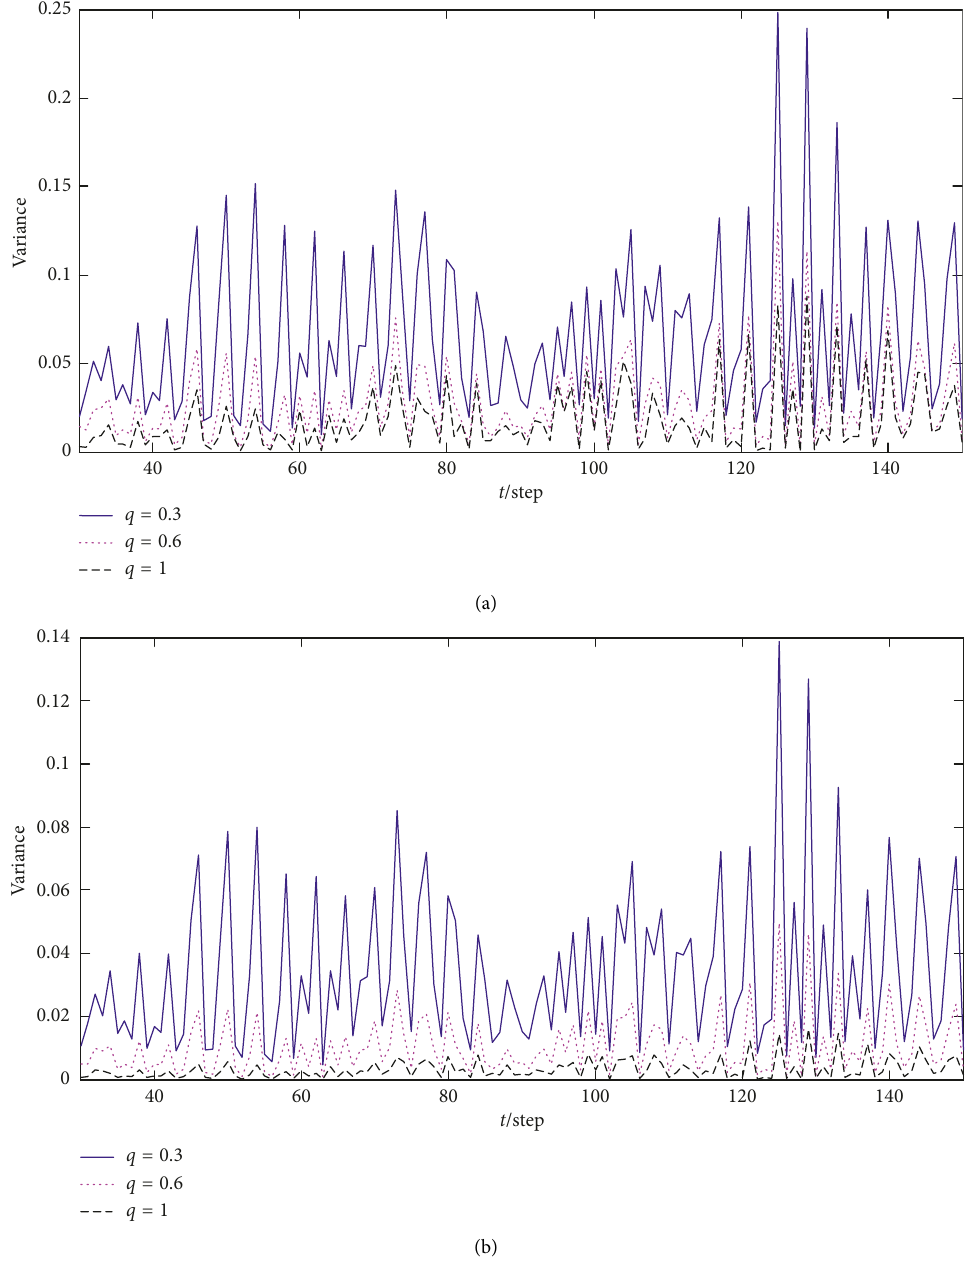
Figure 2: Comparison of error variances of the state filter ( P (b) Estimation error variances for x 2